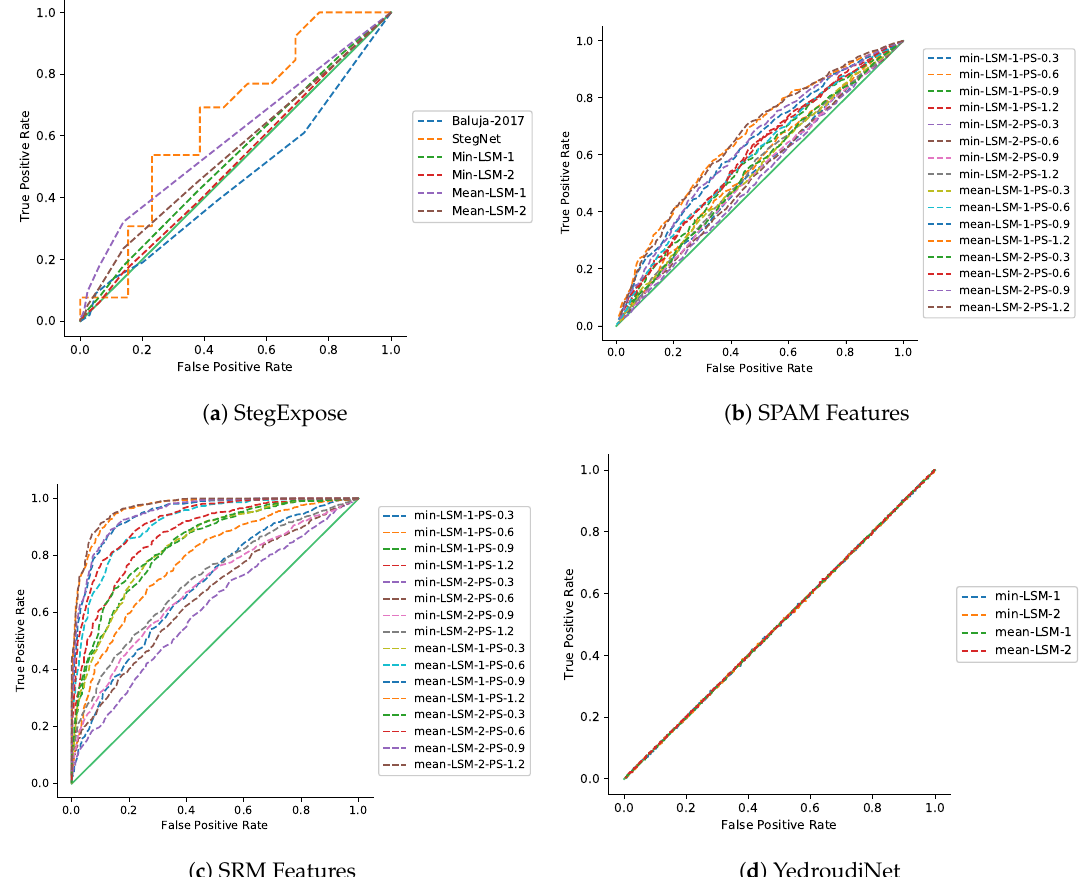
Figure 17. ROC curves: Steganalysis with StegExpose, SPAM features, SRM features and